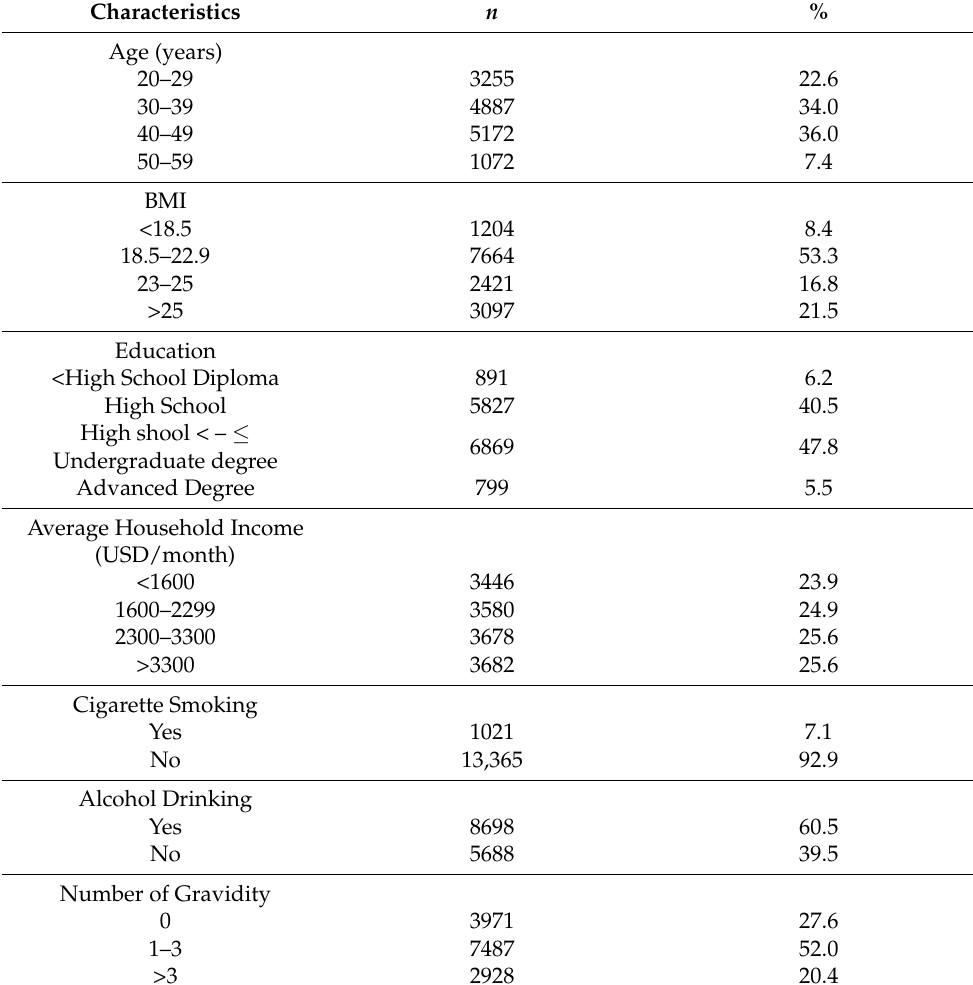
Table 1. Demographic characteristics of the participants.